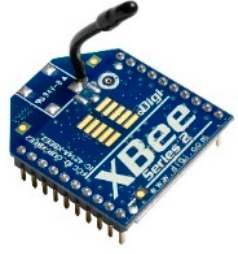
Figure 9. Arduino Uno. Figure 10. Digi XBee serial 2.